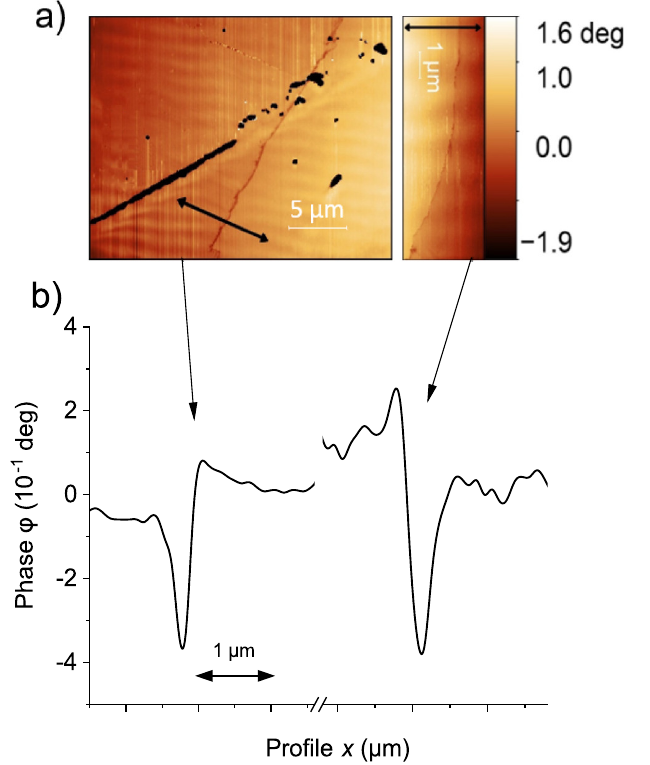
Figure 5. ( a ) MFM scan phase images of the sample at two locations at the opposite ends of the sample near its edges. ( b ) Line scans taken at the black arrows in ( a ). The distance between the two positions is ∼ 1600 µ m.